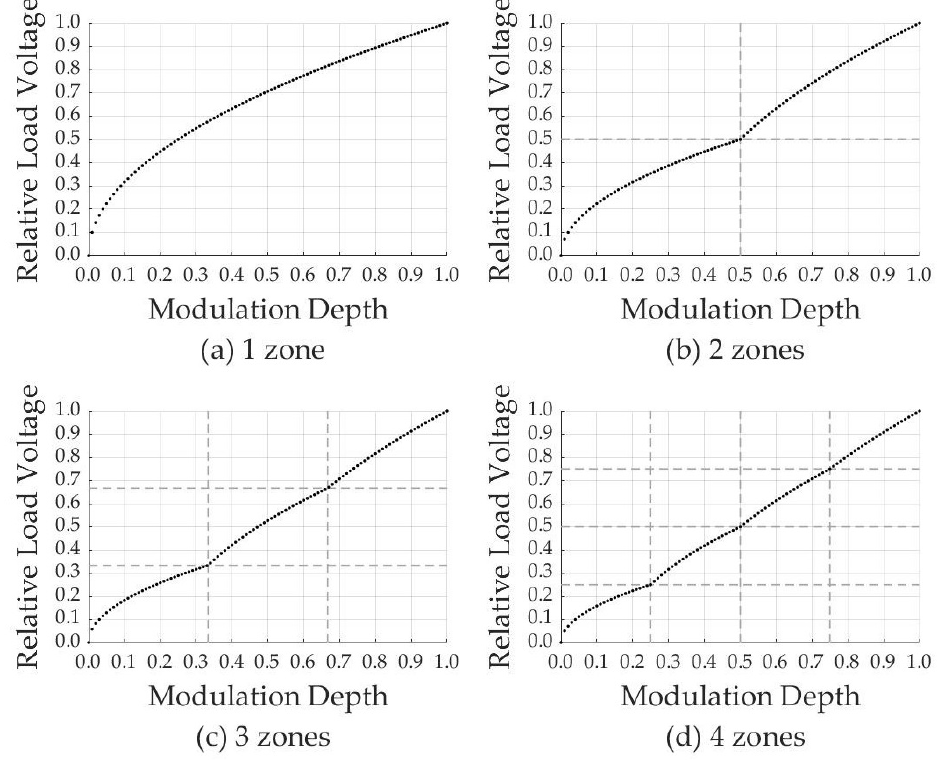
Figure 4. Control characteristics (dependences of relative load voltage on modulation depth) of 1 zone (a), 2 zones (b), 3 zones (c) and 4 zones converter topology.